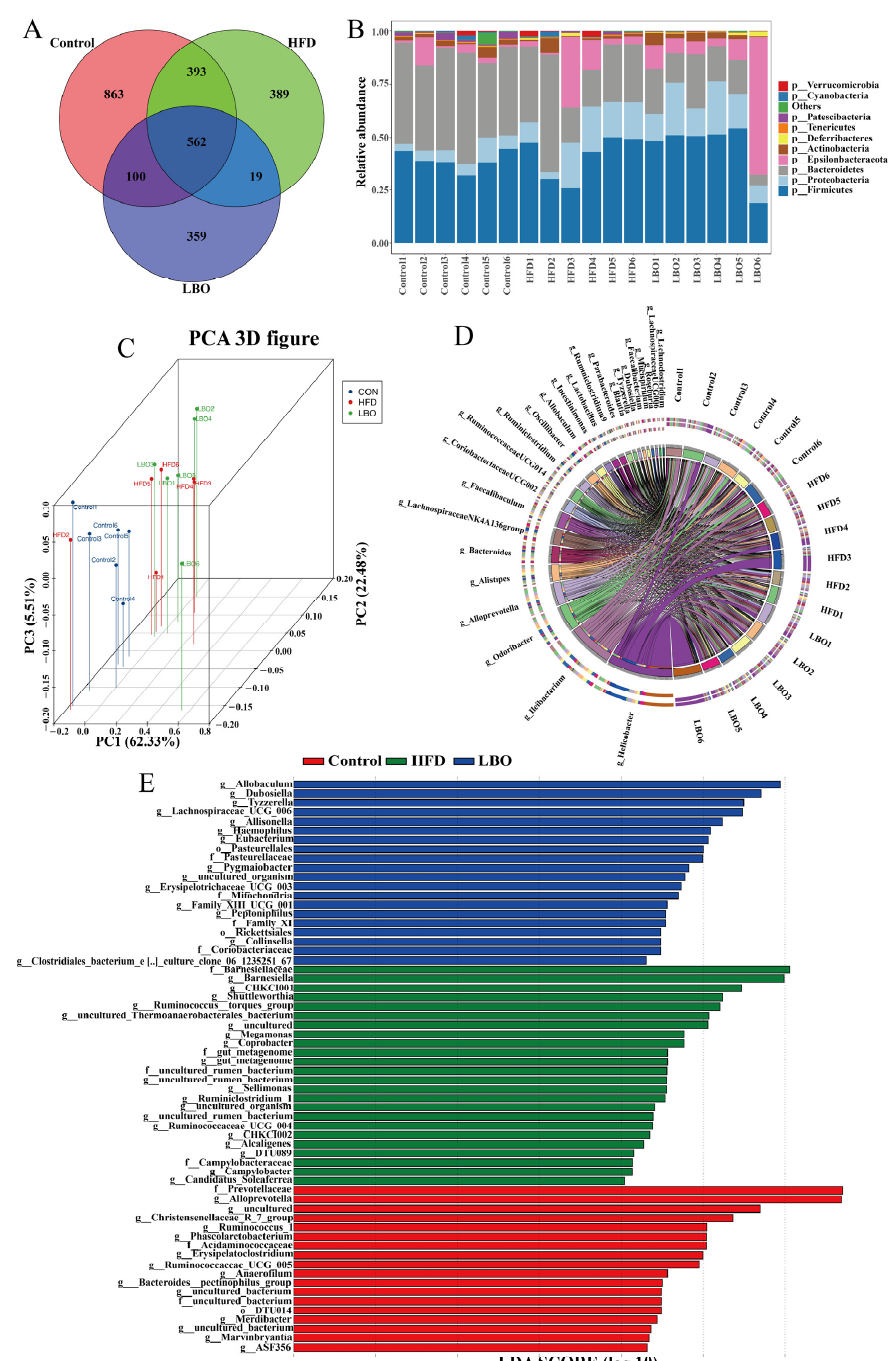
Figure 4. Effect of LBO on the structure and form of the gut microbiota in HFD mice. ( A ) Venn diagram. Different colors represent different groups. The overlapping areas of different colored circles indicate that the different groups were divided into the same OTU. The nonoverlapping parts of different colored circles indicate that each group had a sequence belonging to a different OTU. ( B ) Relative abundance of major microorganisms in the three groups at the phylum level. ( C ) Isolation of fecal microbial structure expressed by PCoA in the three groups. ( D ) The 25 most abundant genera in the different groups. ( E ) Linear discriminant analysis (LDA) effect size (LEfSe) analyses of the three groups at the genus level. LBO: Lycium barbarum oligosaccharide; HFD: high-fat diet; PCoA: principal coordinate